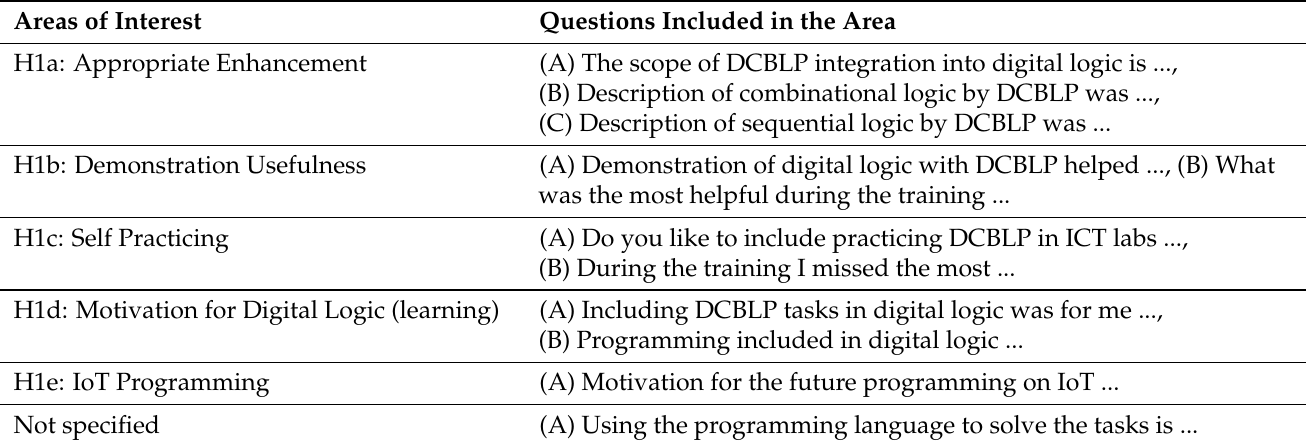
Table 1. Questionnaire